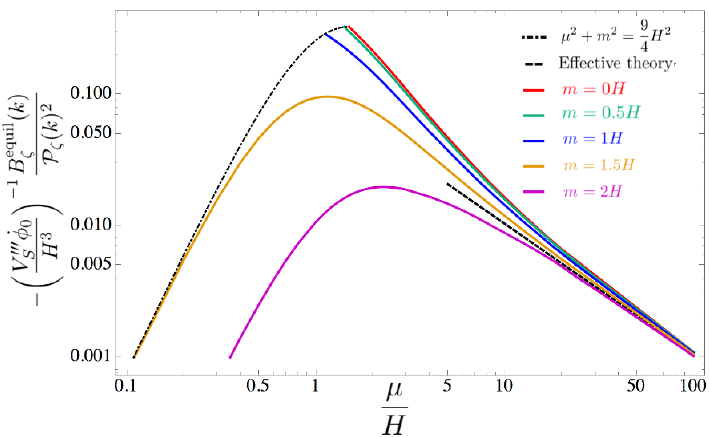
Figure 8 . The scaled equilateral three-point function due to the s 3 interaction, B equil as a function of (cid:22)=H . Several values of m are plotted: m = 0, 0 : 5 H , H , 1 : 5 H , and 2 H , and there is also a black dashed line representing the result computed in the large (cid:22)=H e(cid:11)ective theory. In (cid:12)gures 7 and 8, we plot the contributions to the scaled equilateral three-point